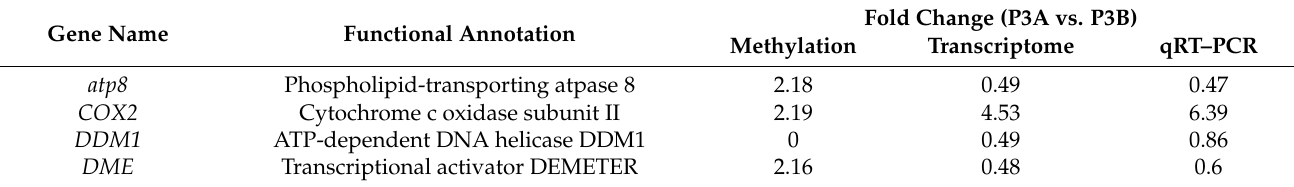
Table 3. qRT–PCR validation of the RNA-seq